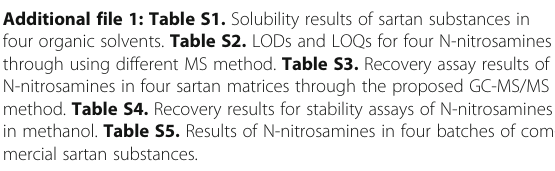
Additional file 1: Table S1. Solubility results of sartan substances in four organic solvents. Table S2. LODs and LOQs for four N-nitrosamines through using different MS method. Table S3. Recovery assay results of N-nitrosamines in four sartan matrices through the proposed GC-MS/MS